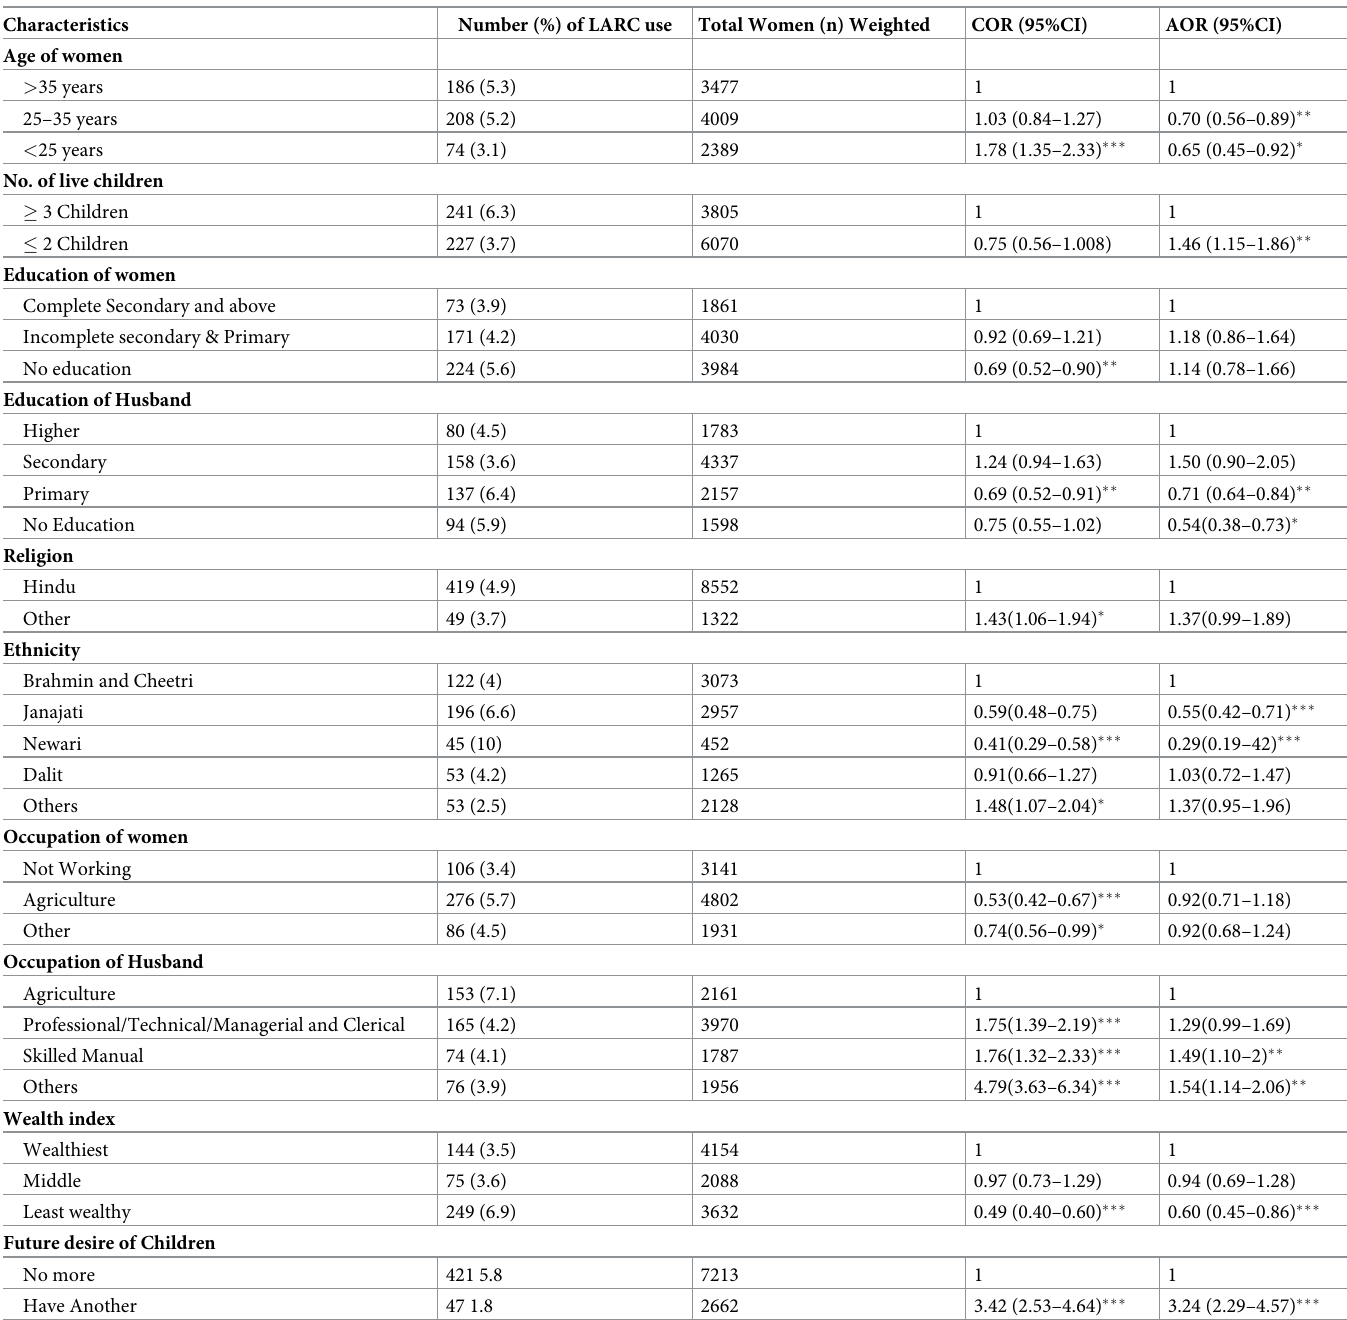
Table 3. Effects of socio-demographic and economic and fertility related characteristics on use of